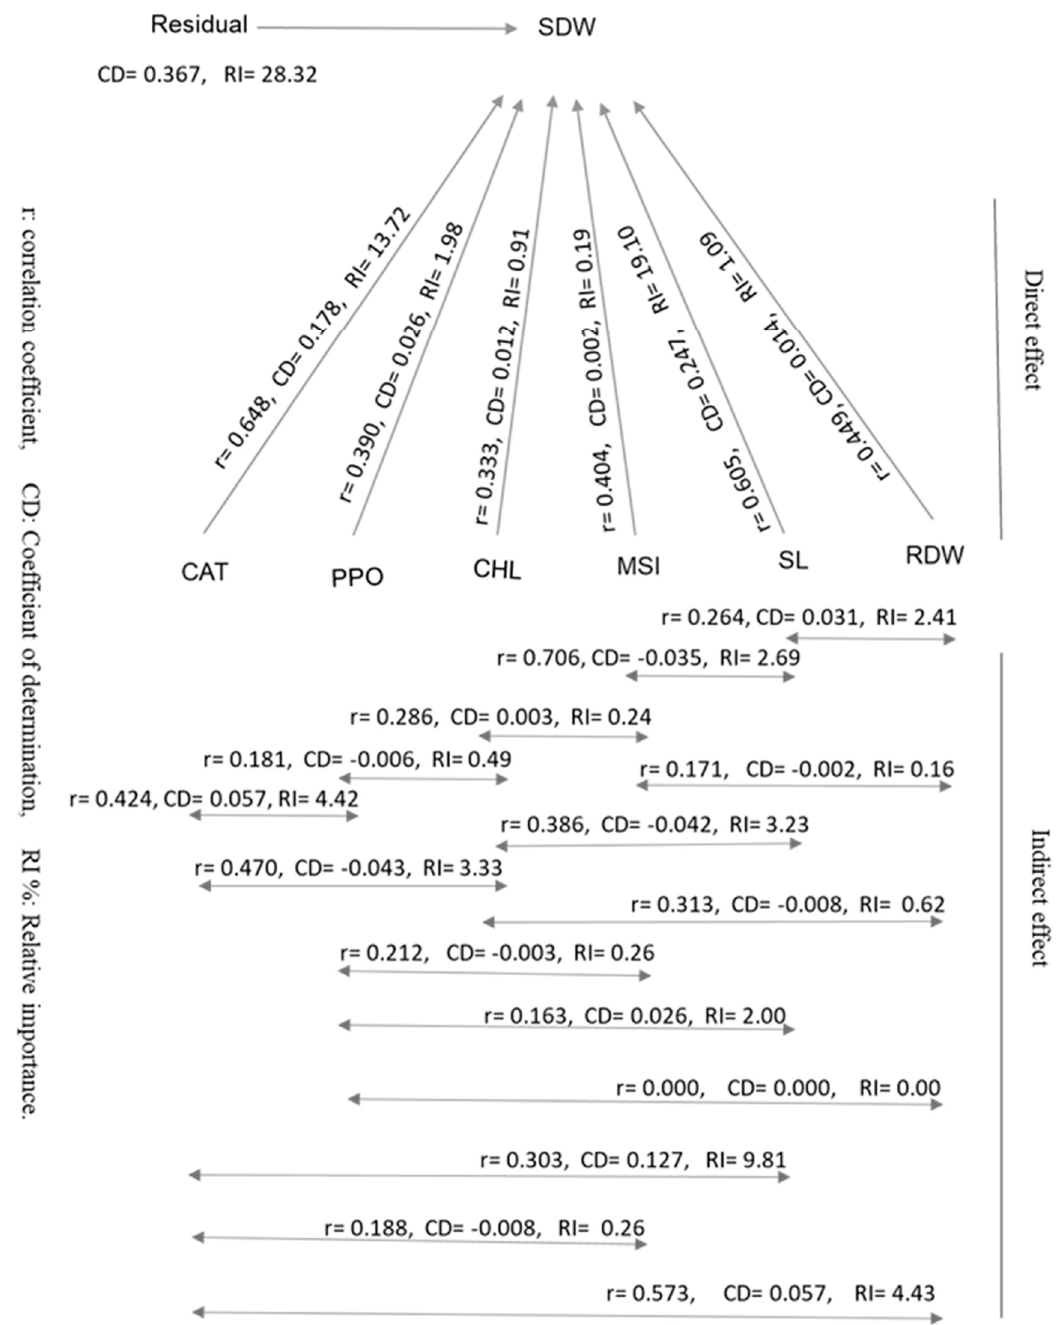
Figure 5. Path analysis (direct and indirect effects) to estimate six related attributes with shoot dry weight of wheat. Root dry weight (RDW), shoot length (SL), shoot dry weight (SDW, membrane stability index (MSI), chlorophyll content (CHL), polyphenol oxidase (PPO), and catalase (CAT).